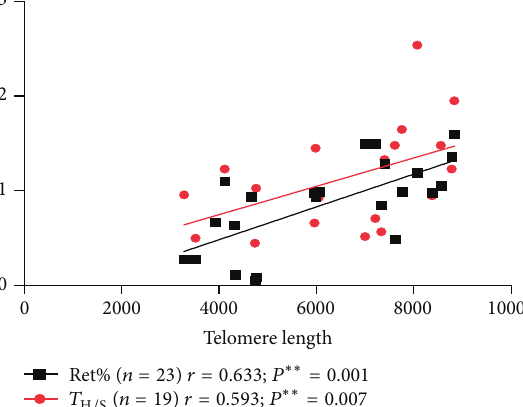
Figure 1: Telomere length of PWBCs.